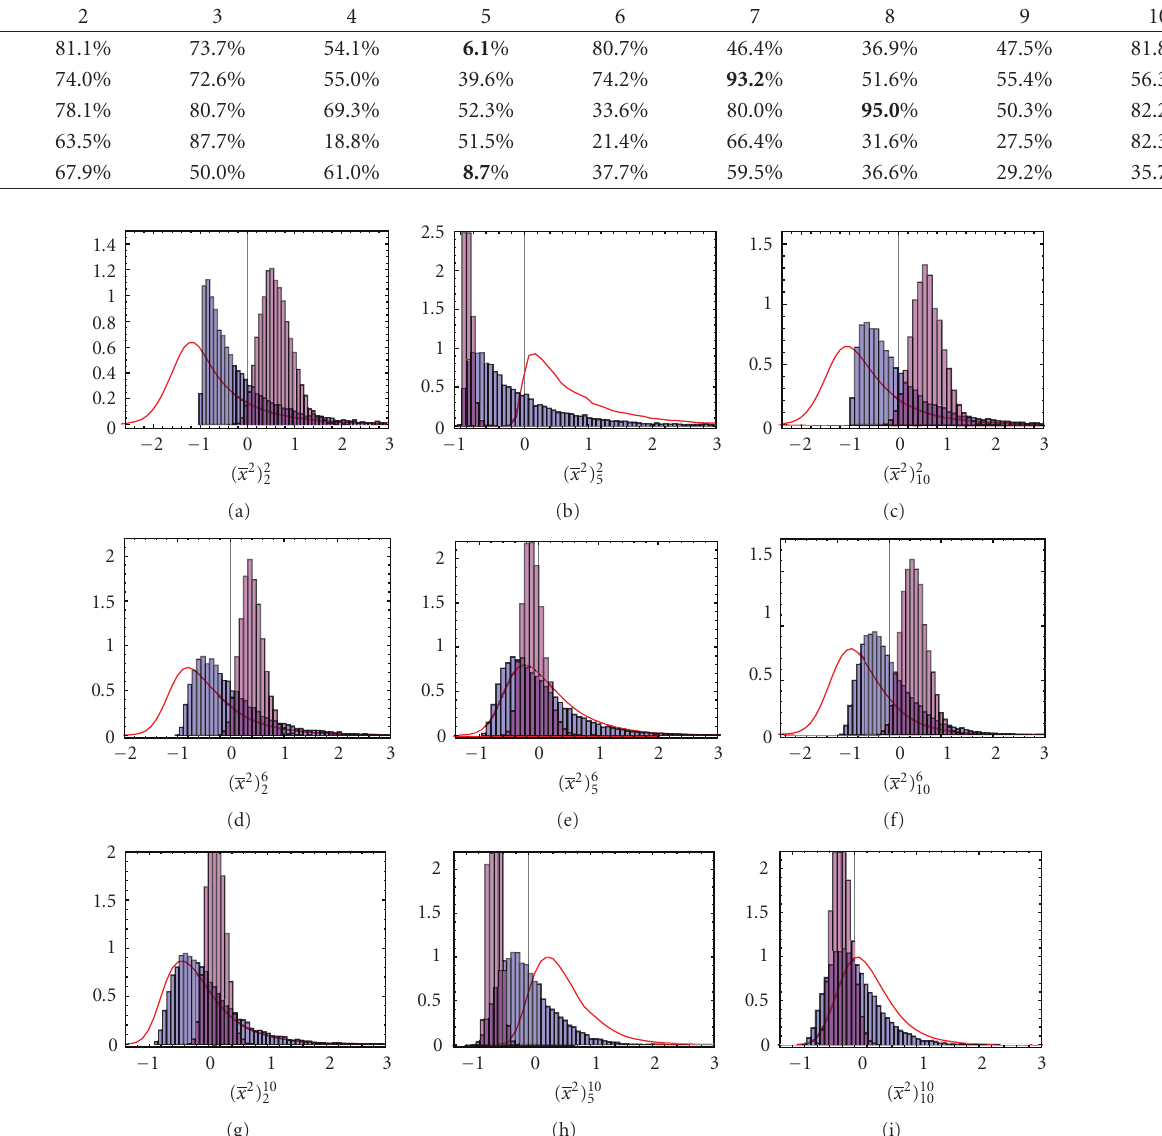
− ( χ 2 ) l (solid, red line). We show only a few (cid:5) (th) (cid:5) (obs)